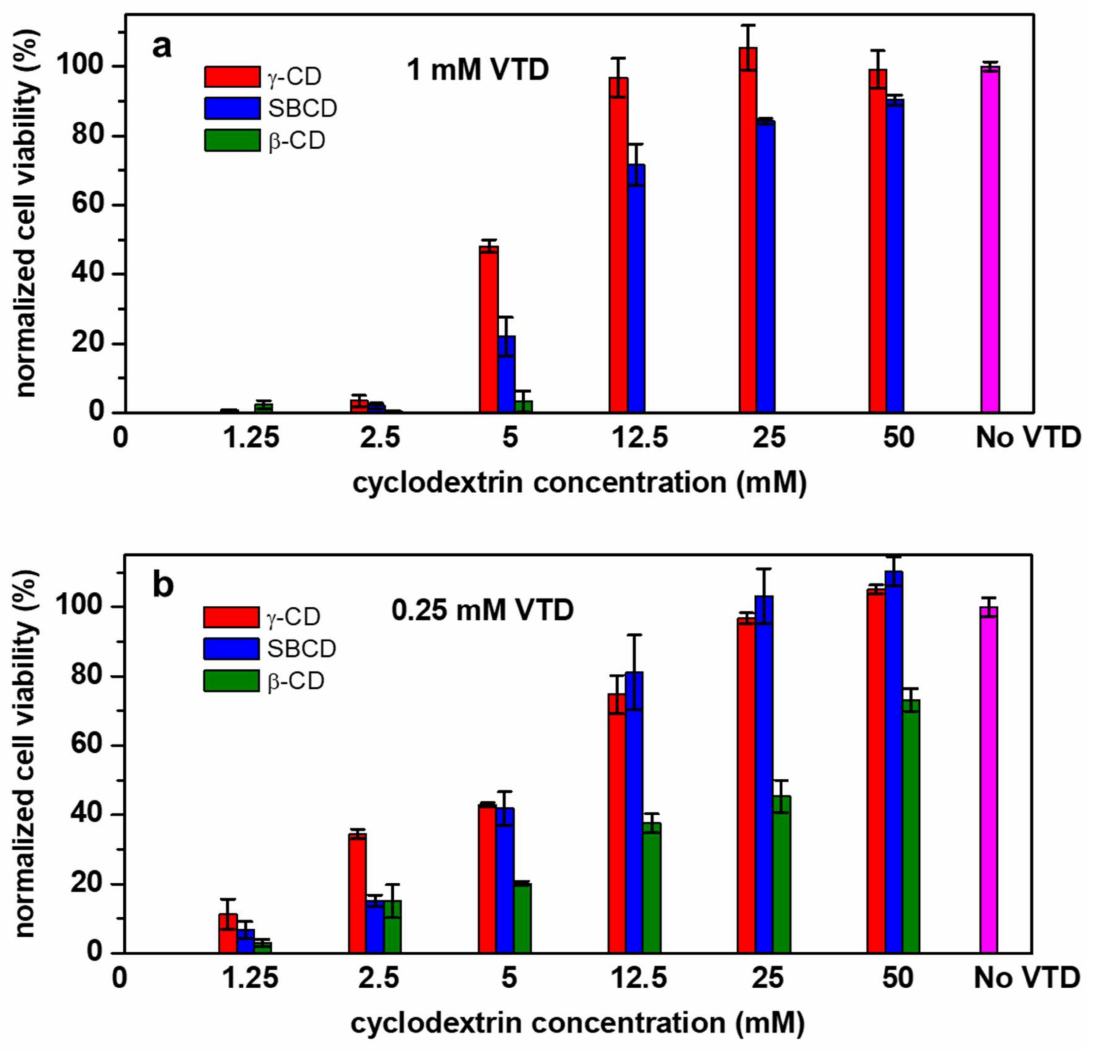
Figure 10. Normalized cell viability of Neuro-2a cells pre-treated with 0.4 mM ouabain (OB) after the incubation with ( a ) 1 mM and ( b ) 0.25 mM VTD in the absence (0 mM) and in the presence of γ -CD (red), SBCD (blue) and β -CD (green) at different concentrations. The control in absence of VTD is the magenta